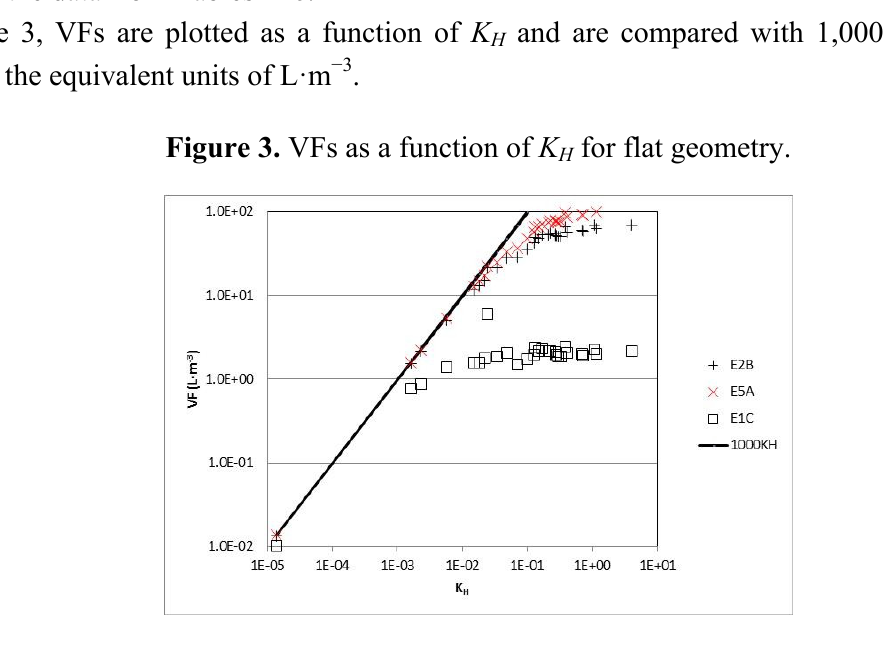
Figure 3. VFs as a function of K